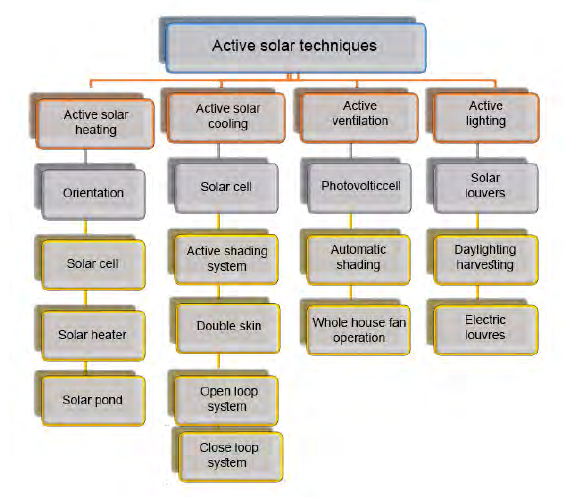
Figure 2. activesolar strategies to reduce energy consumption inside buildings (Ashmawy,